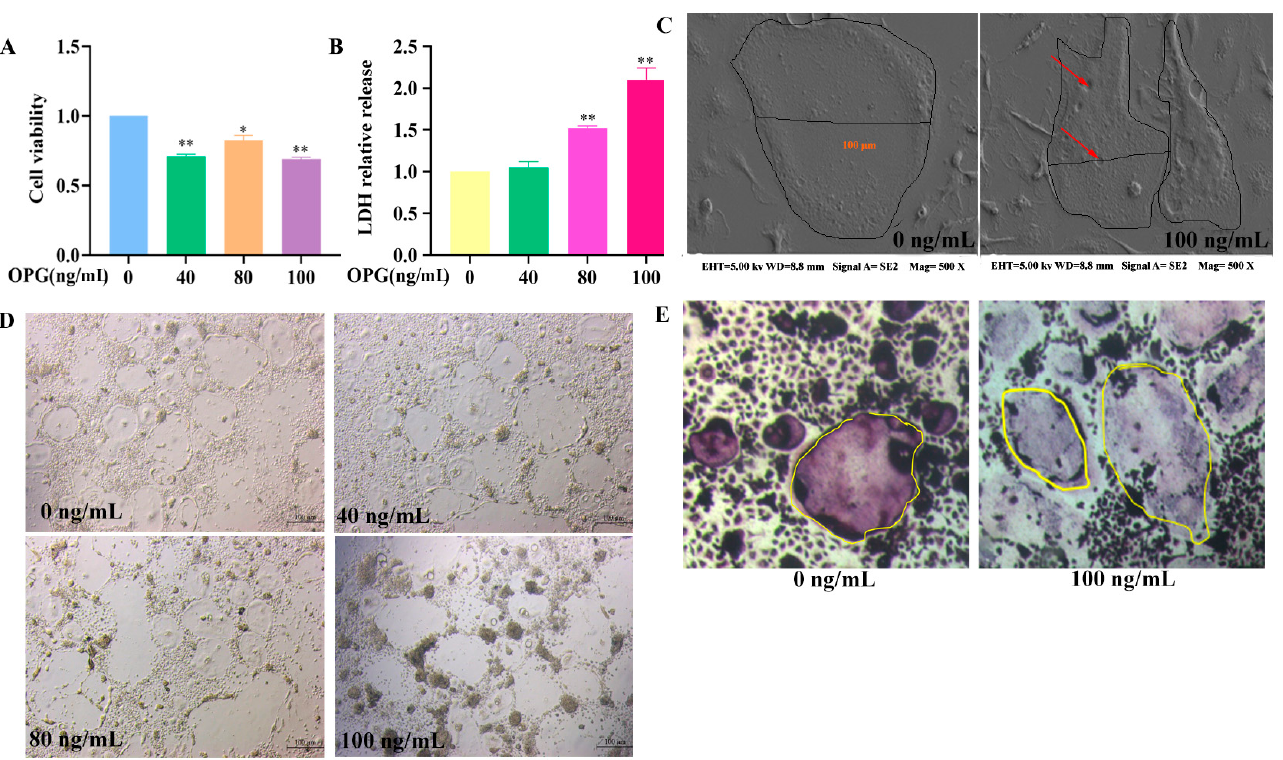
Figure 1. Effect of OPG on survival rate and cell membrane integrity of osteoclasts. ( A ) Cell viability was analyzed by CCK-8. ( B ) LDH release was examined by ELISA. ( C ) SEM was used to observe the morphology of osteoclasts; magnification is 500 × . ( D ) osteoclasts’ morphology was observed by microscope; scale bar =100 µ m. ( E )—Mature osteoclasts were stained with TRAP; scale bar = 50 µ m. (mean ± SD, n = 3, * p < 0.05, ** p < 0.01).